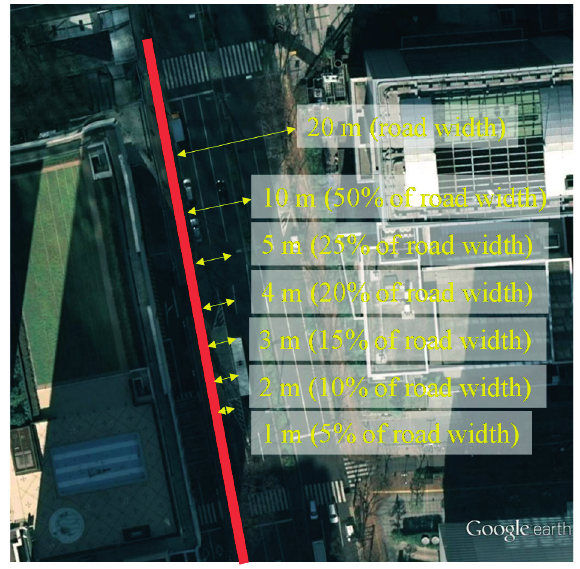
Figure 14. Demonstration of the bins of the histogram of the lateral positioning error. The red line indicates the pedestrian walking